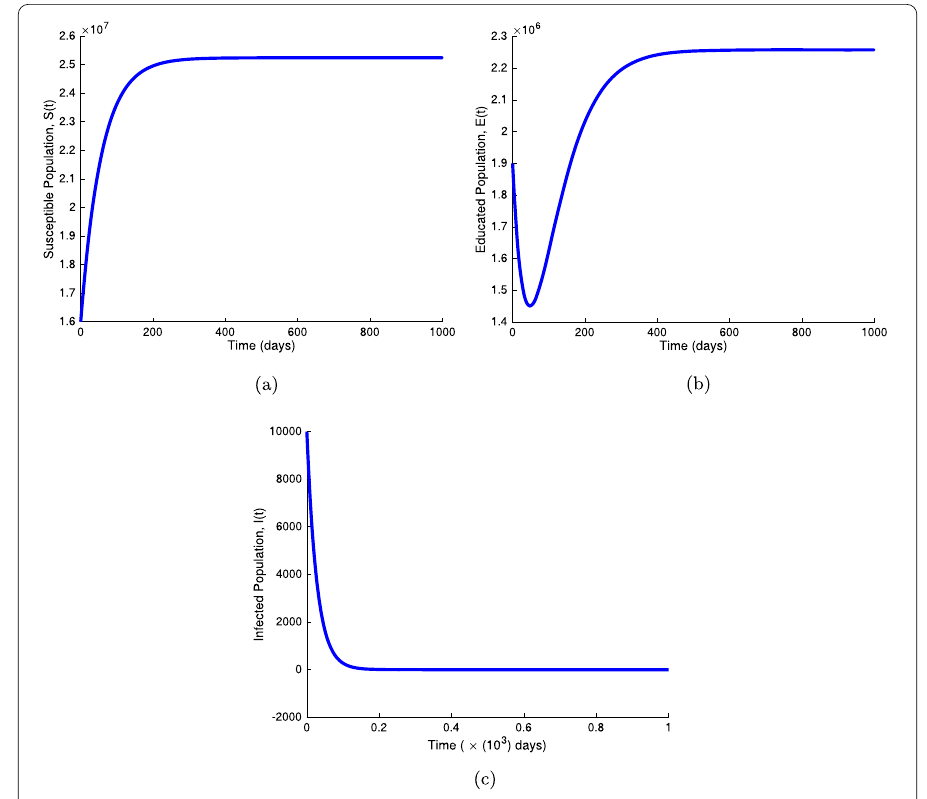
Figure 2 The dynamics of susceptible ( a ), educated ( b ), and infected ( c ) populations in model system (1) when R E = 0.19090 < 1. Used parameter values are in Table